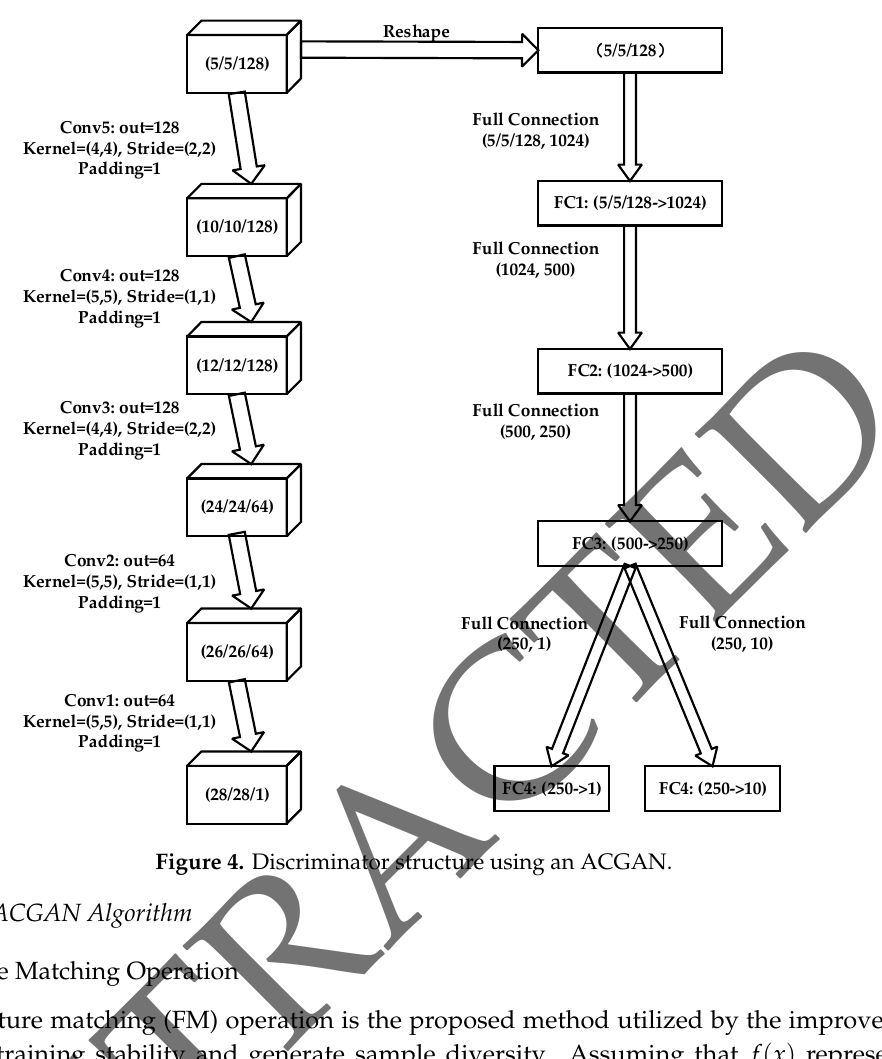
Figure 4. Discriminator structure using an ACGAN.